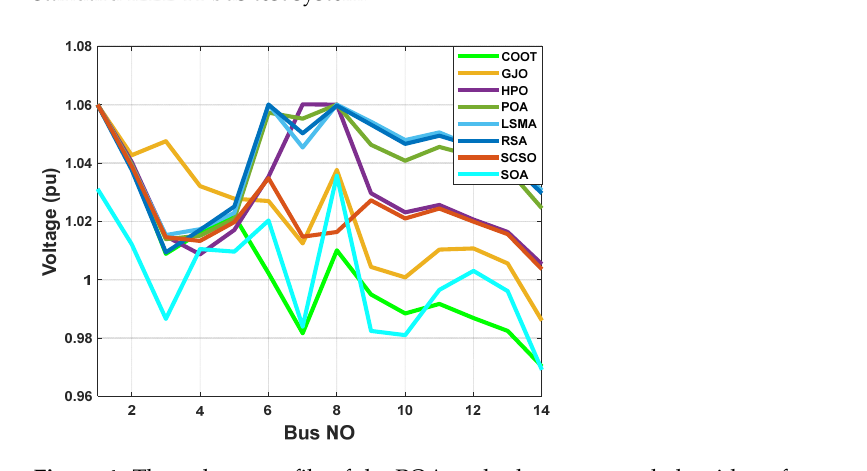
Figure 5. Boxplot of POA and other compared algorithms for case 1 in a standard IEEE 14-bus test system. Case 2: Power Losses Minimization Real power loss was the desired outcome here. The POA algorithm was utilized to arrive at the most efficient solution, the results of which are given in Table 3. The POA algorithm is extremely useful for establishing the precise settings of the control variable, which diminishes system losses. As a result, when the POA algorithm is used, real power losses are reduced to 0.498 MW. In Figure 6, real power losses utilizing the POA method are steeply convergent while taking other comparative techniques into account. Within 50 iterations, the algorithm reaches the optimum solution, demonstrating how rapidly it con- verges. The evaluated real power loss is compared to that found before using published population-based optimization techniques in order to assess the performance of the ap- proach. Table 3 demonstrates how the POA algorithm outperforms these prior methods. As shown in Figure 7, heuristic optimization algorithms produce feasible results. The rea- son for this is the magnitude of voltage accepted on all system load buses. Figure 8 shows a boxplot of results for each approach with further analysis to support the performance of the suggested technique.